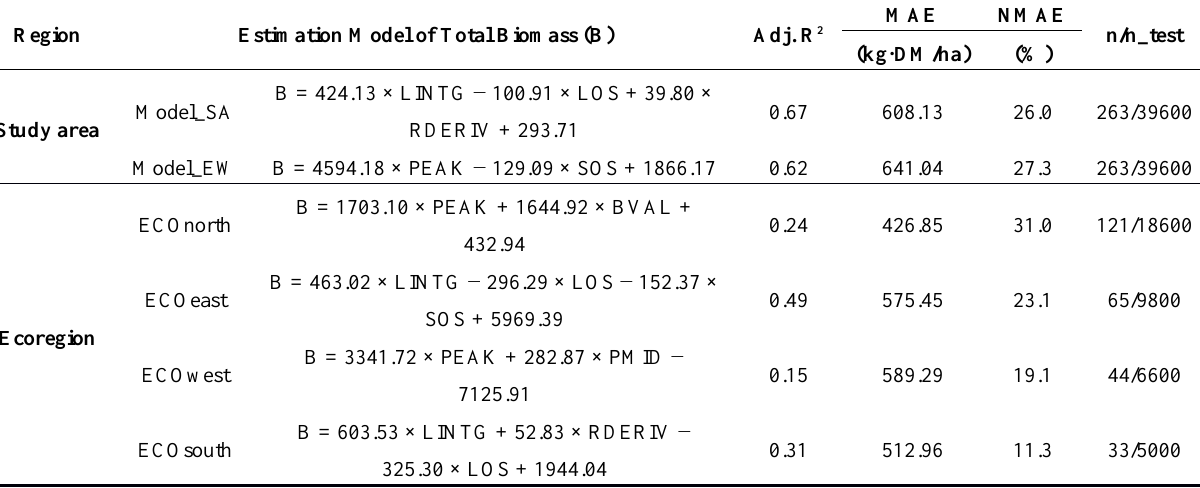
Table 5. Calibration and bootstrap verification performances of multiple linear regression models for total biomass estimation across the study area and per ecoregion. “n” is the size of the original sample used for calibration and “n_test” is the size of the bootstrap sample used for statistical calculations of verification. For other acronyms, see Tables 2 and